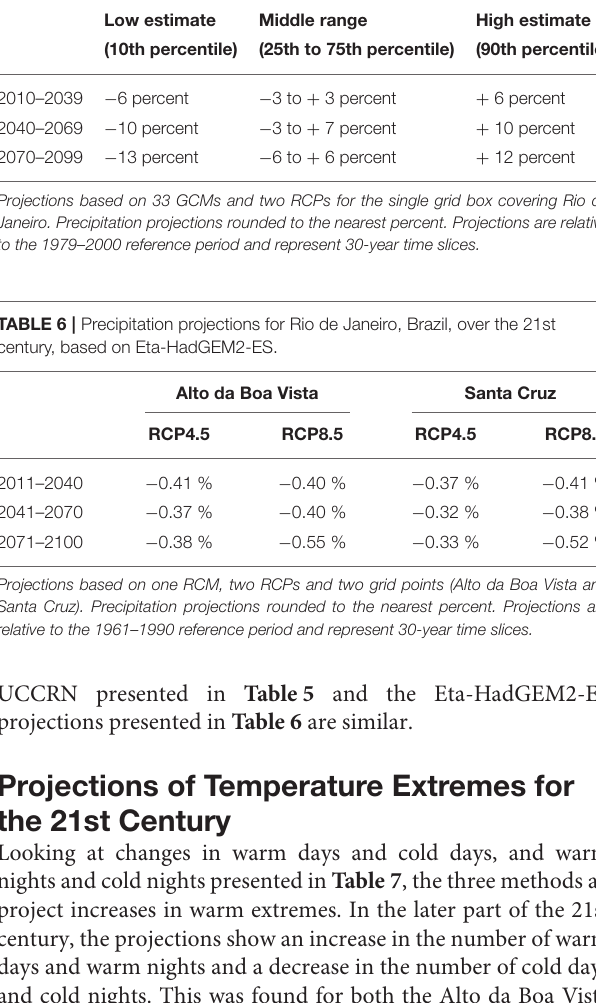
TABLE 3 | Temperature projections using the UCCRN method for Rio de Janeiro, Brazil, over the 21st century. Low estimate